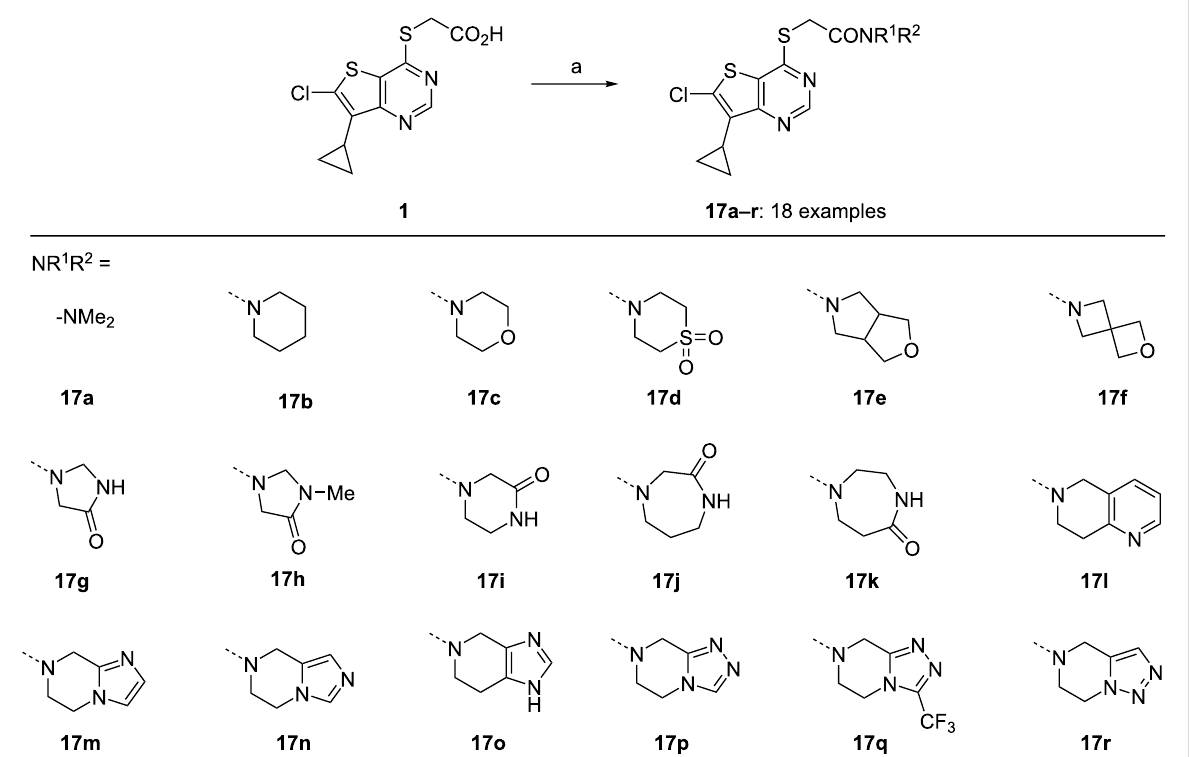
Scheme 4: Preparation of amides 17 . Representative reagents and conditions a : (a) HBTU (1.1 equiv), iPr 2 NEt (2.5 equiv), DMF, rt, 15 min; then amine 18 (1.05 equiv). a These reactions were performed once for each amide and have not been optimised. DMF, N,N -dimethylformamide;